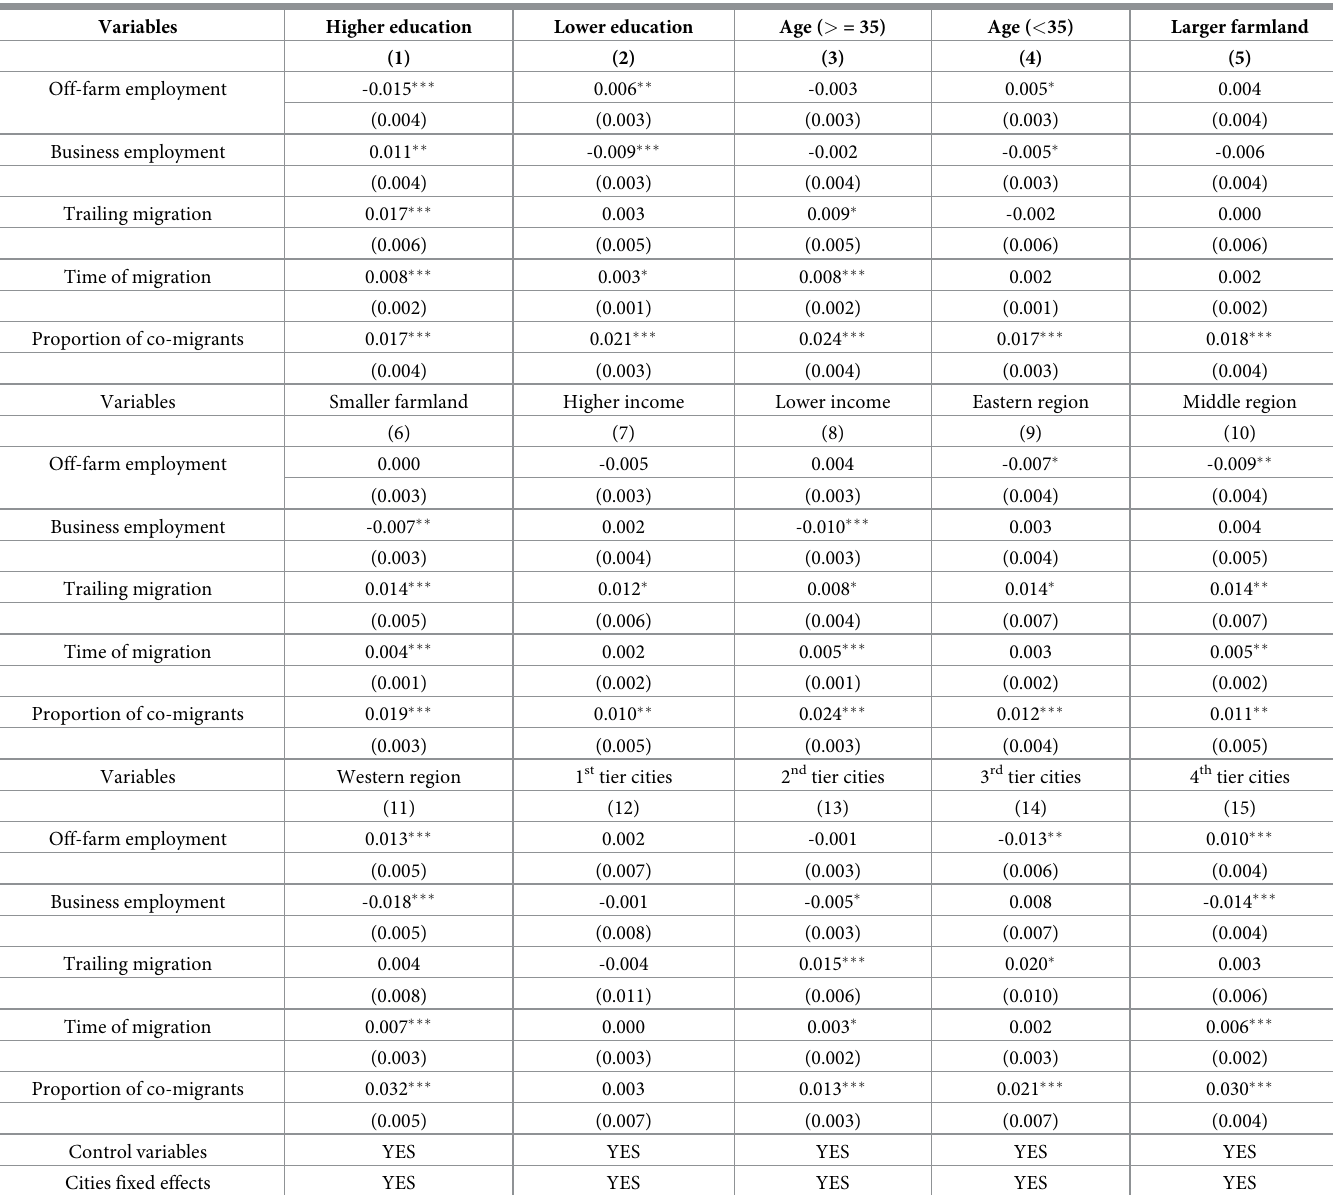
Table 6. The heterogeneous analysis results—farmland